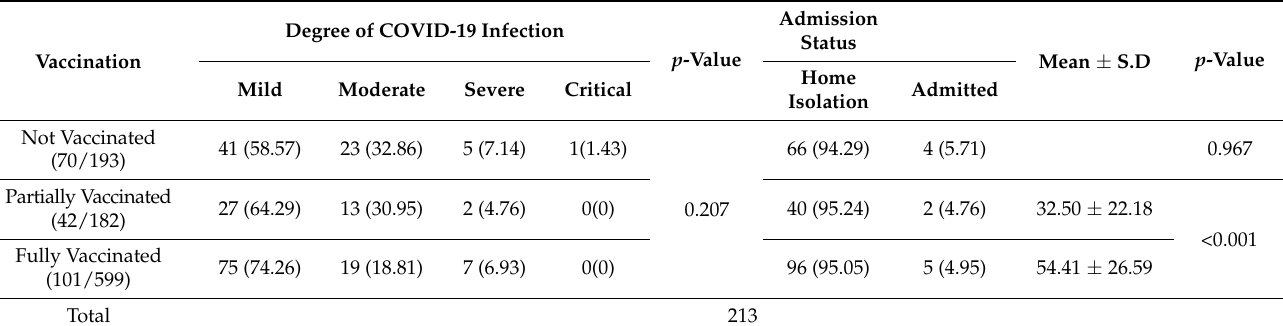
Table 2. COVID-19 vaccine effectiveness among HCWs by number of COVID-19 vaccine